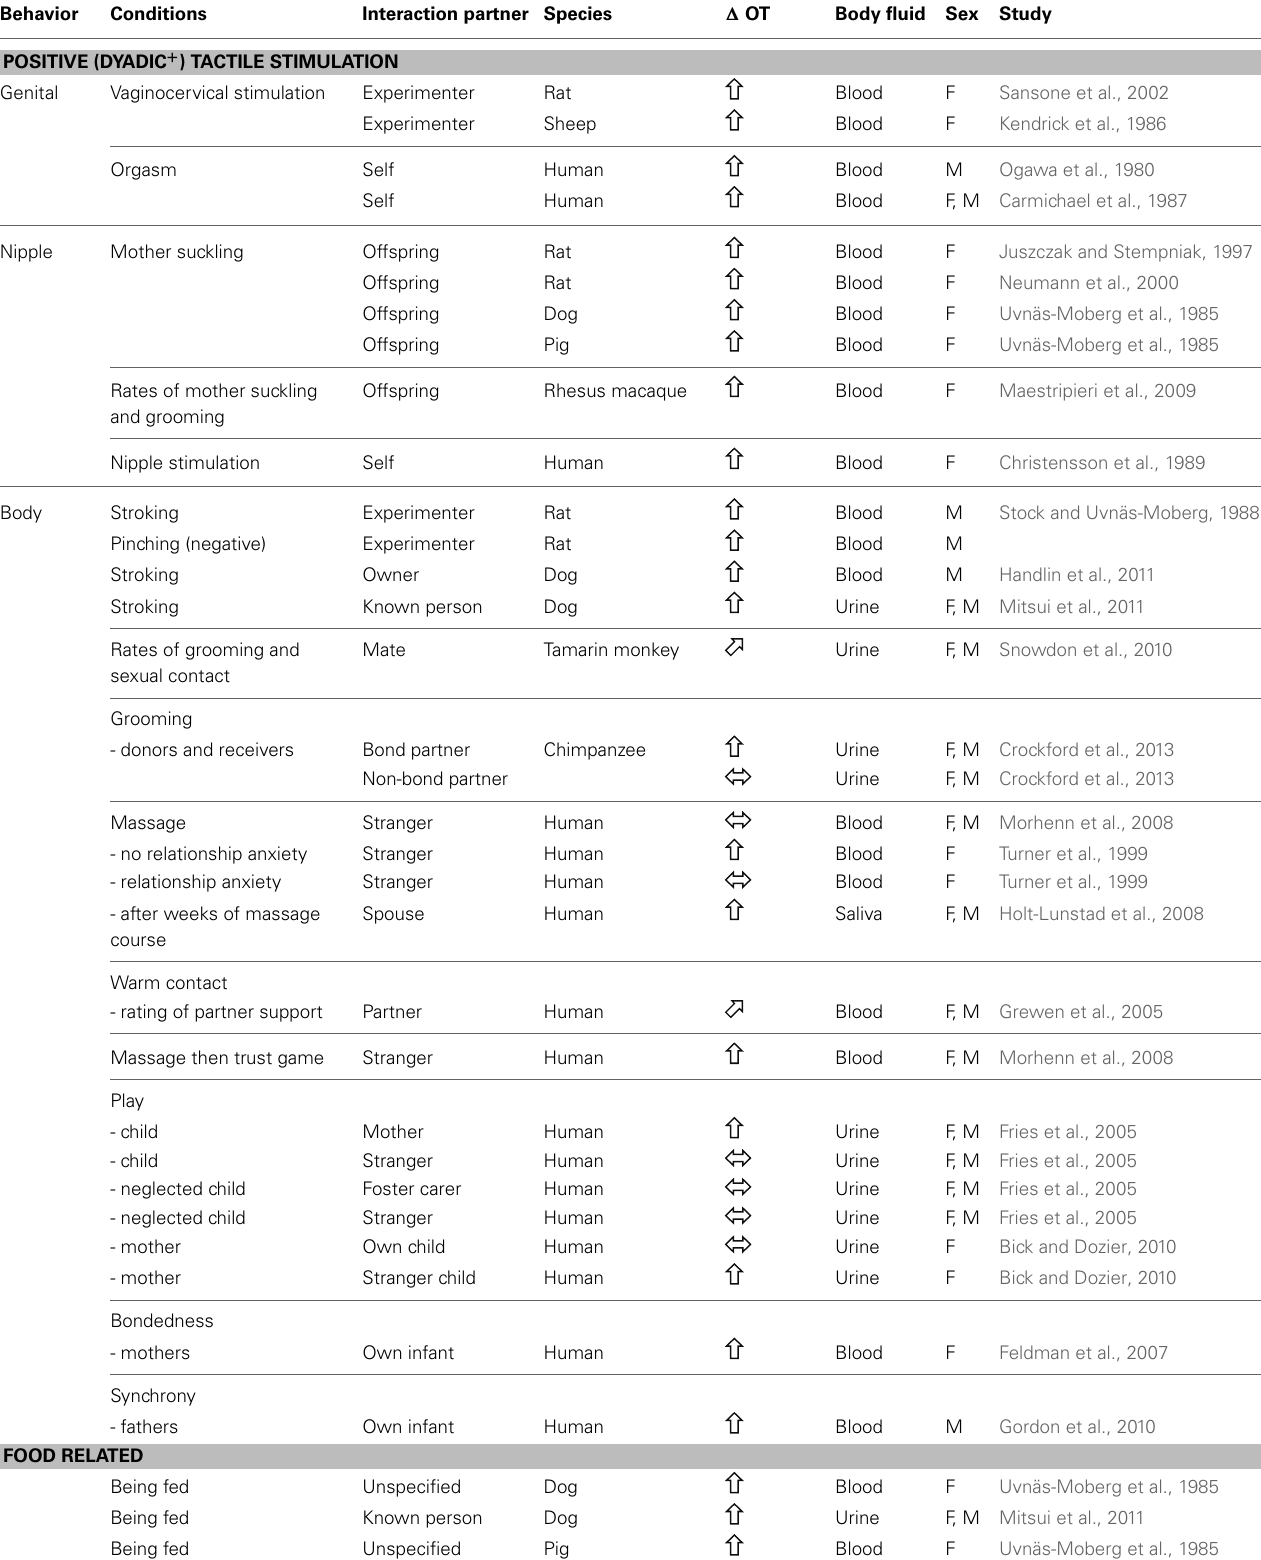
Table 1 | The relationship between specific social behaviors and endogenous peripheral oxytocin levels compared with baseline